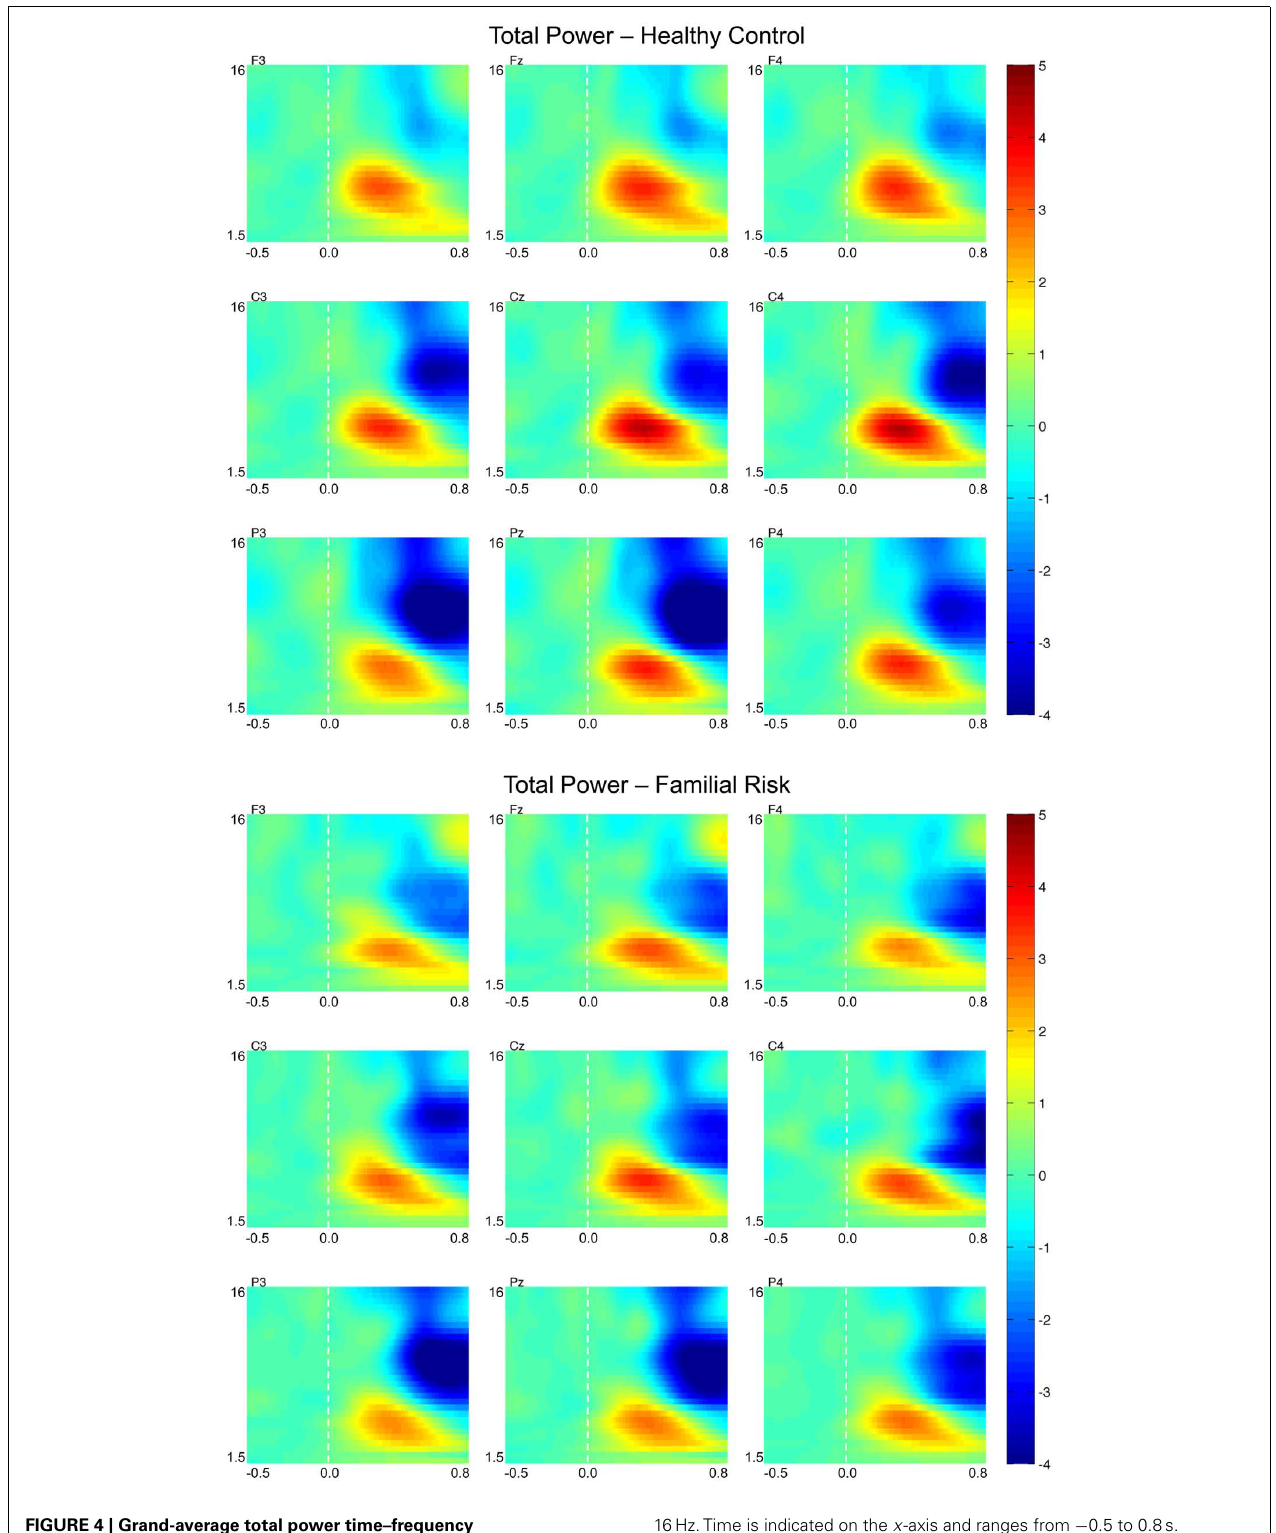
FIGURE 4 | Grand-average total power time–frequency transformations for healthy control (HC) and familial risk (FR) groups at electrodes F3, Fz, F4, C3, Cz, C4, P3, Pz, and P4. EEG frequency is indicated on the y -axis for all panels ranging from 1.5Hz to